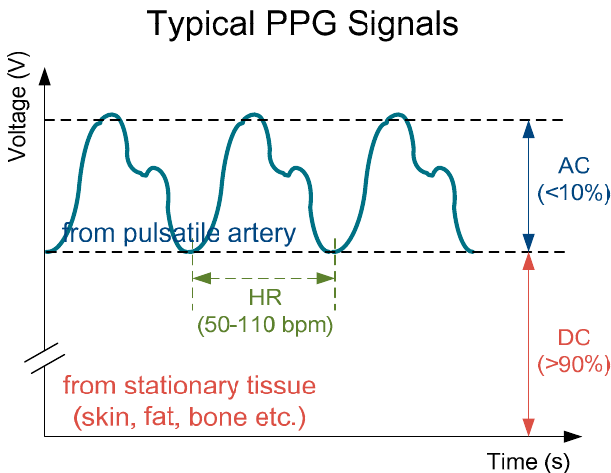
Figure 2. A typical photoplethysmography (PPG) signal consisting a large stationary part (>90%) and a small pulsating part (<10%) with a pulse frequency same as the heart rate (about 50–110 bpm).